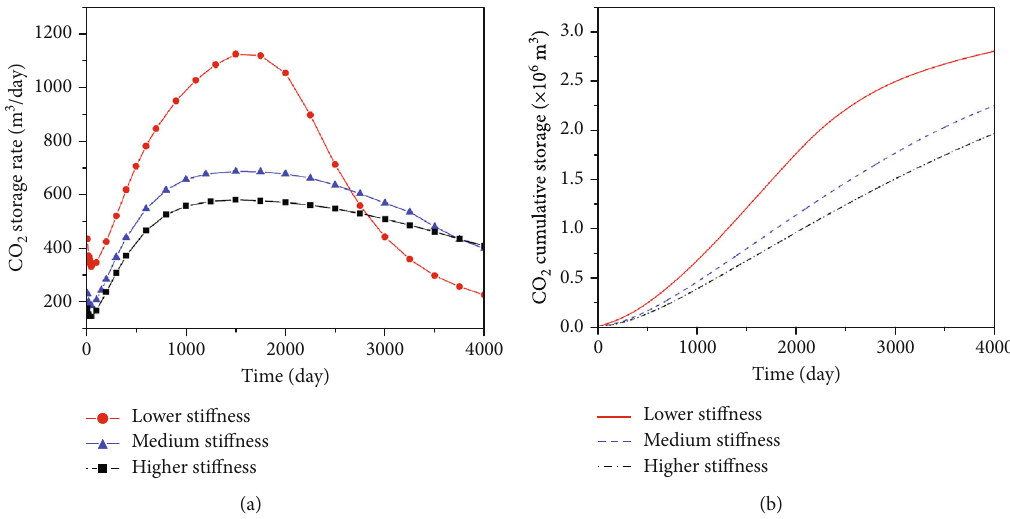
Figure 11: CO storage of di ff erent sti ff ness of coal seams. (a) Storage rate. (b) Cumulative storage. 2